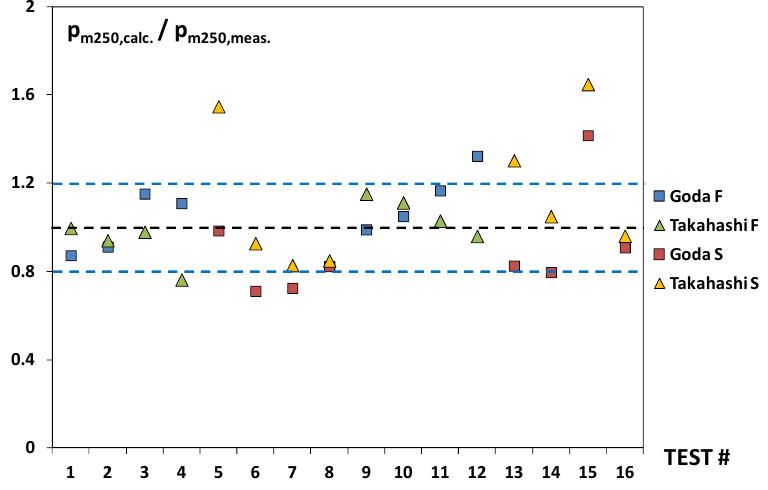
Figure 13. Comparison between measured and predicted values of the mean pressures along the wall. In abscissa the test